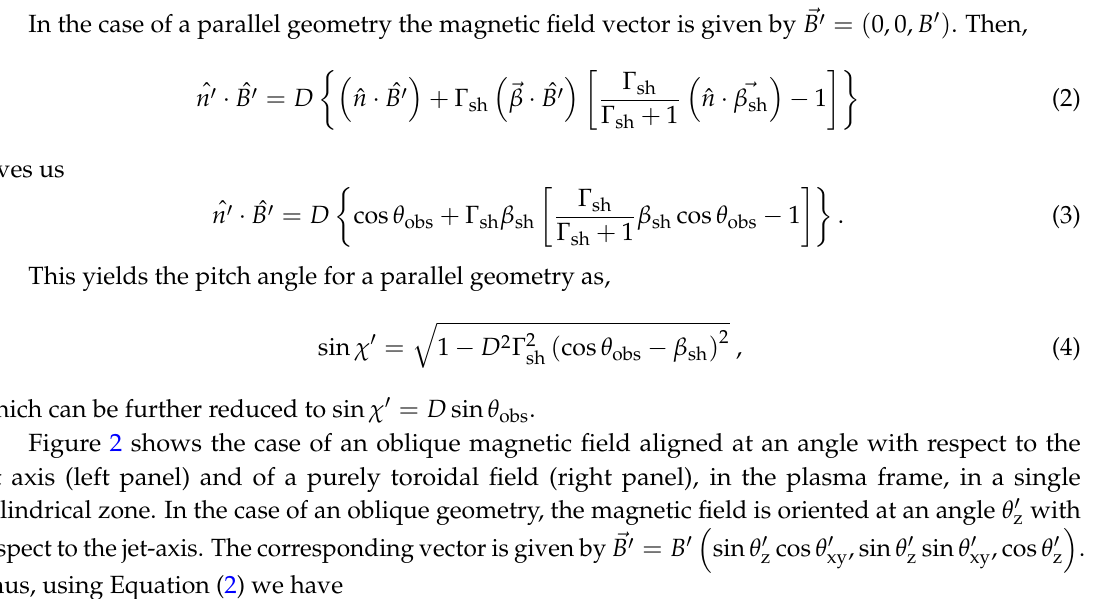
Figure 1. Schematic diagram of the geometry of a parallel magnetic field with respect to the jet axis ( z -axis) in a single cylindrical zone (in the comoving frame of the emission